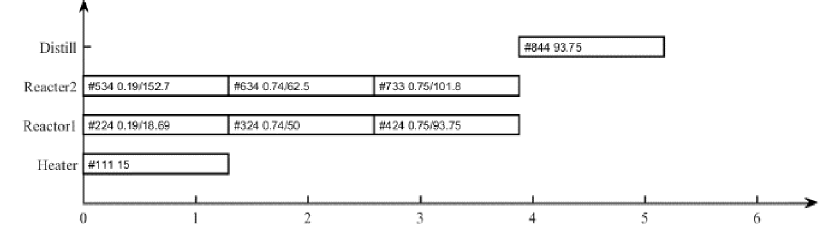
Fig. 8. MINLP problem Gantt charts.